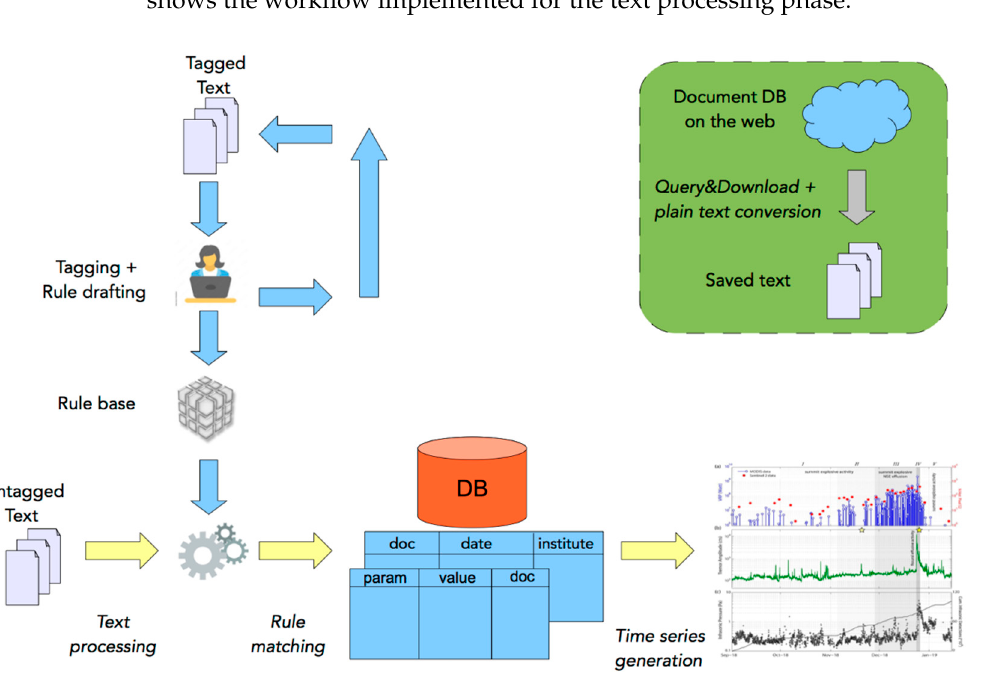
Figure 2. System architecture.